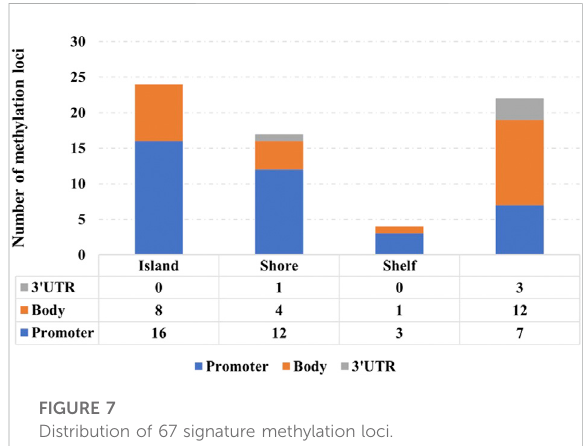
FIGURE 7 Distribution of 67 signature methylation